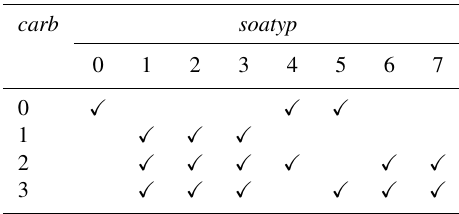
Table 7. Correspondence between the different carb and soatyp flag values. carb